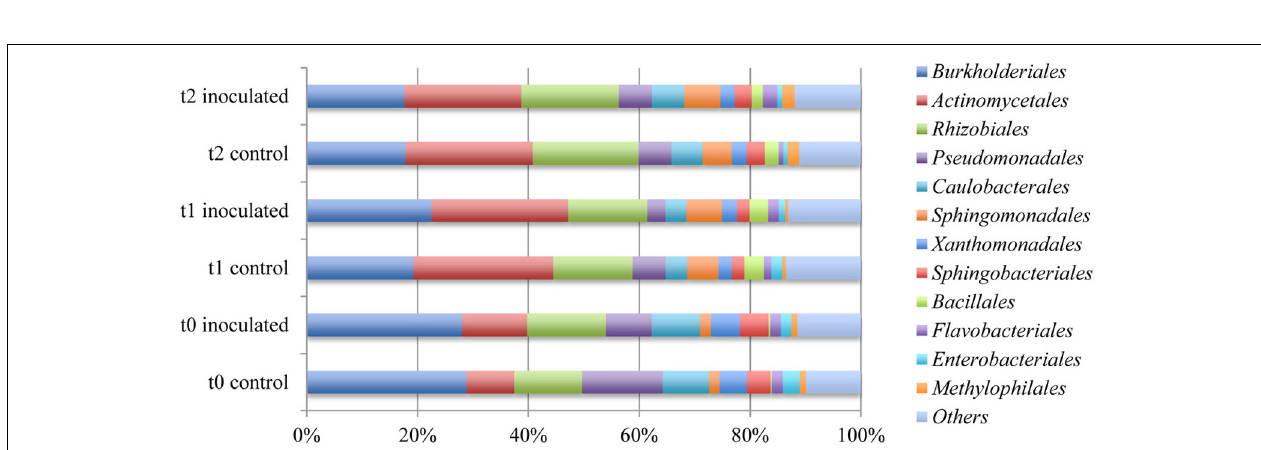
FIGURE 5 | Comparison of the ten most abundant orders within the rhizosphere of lettuce. Abundances were calculated by means of comparison of metagenome sequence reads against the GenBank database within the MG-RAST software